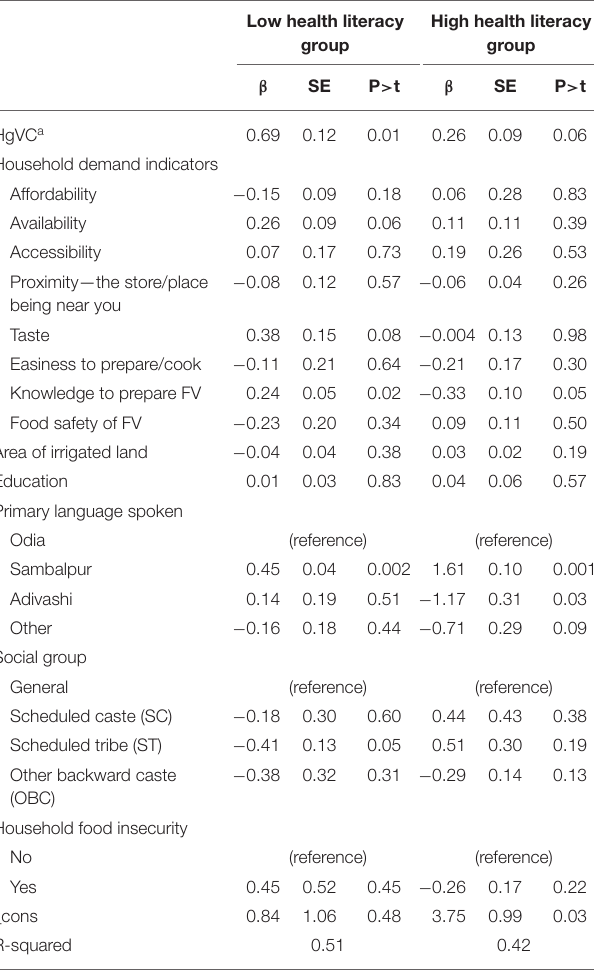
Low health literacy High health literacy group